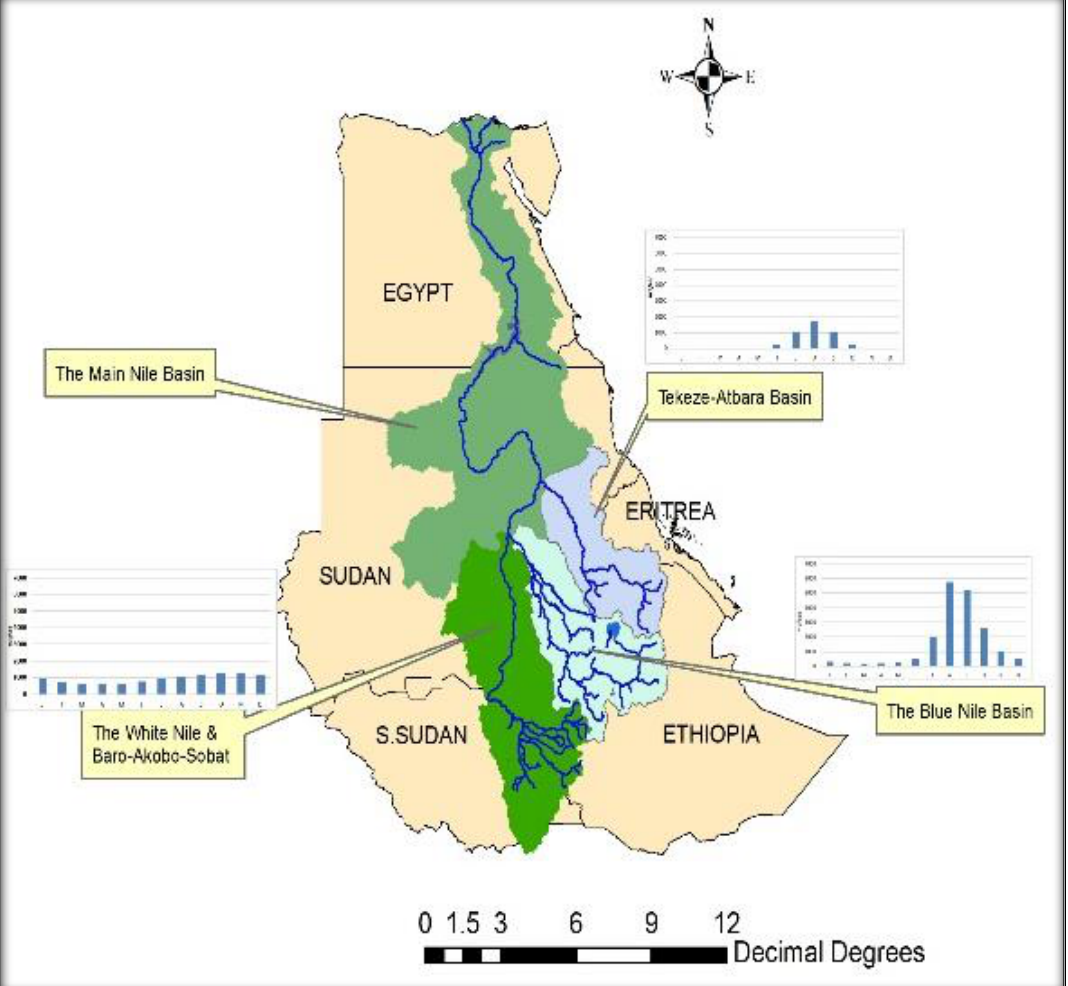
Figure 2. The seasonal contribution of sub-basins.